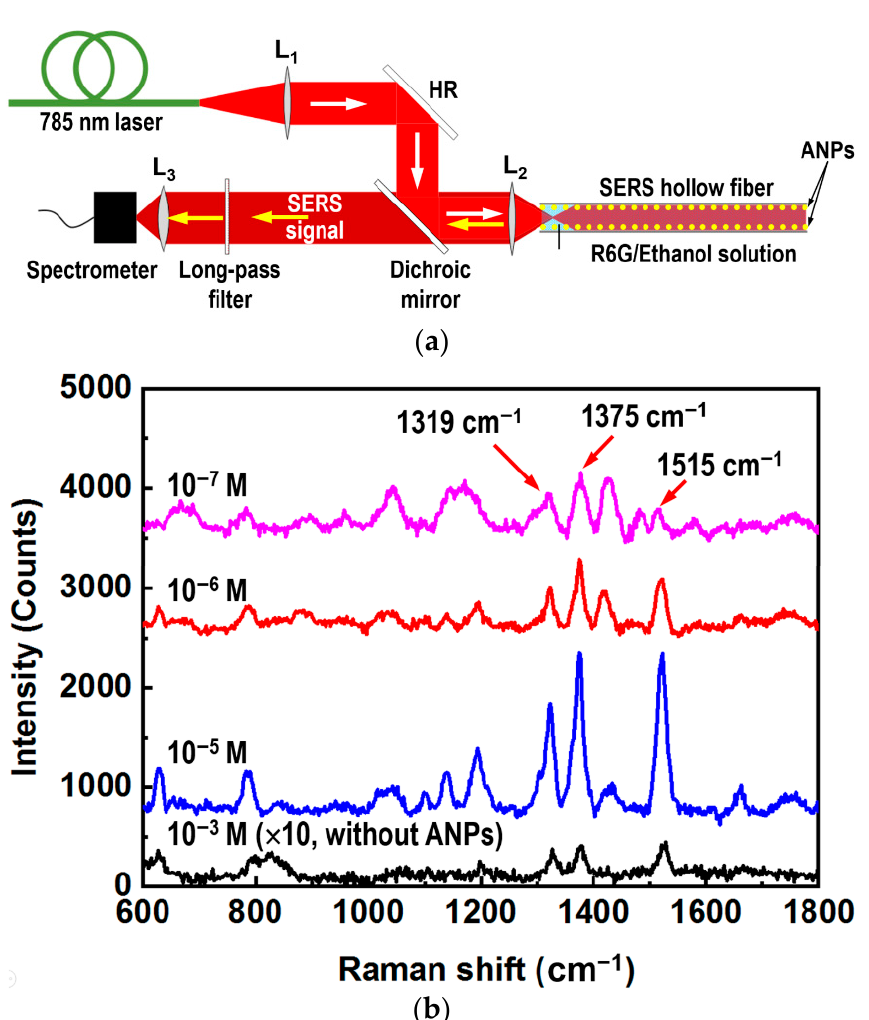
Figure 4. ( a ) Schematic illustration of the SERS detection system. ( b ) SERS signal spectra measured at different concentrations of the R6G/ethanol solution: 10 − 3 M (black), 10 − 5 M (blue), 10 − 6 M (red), and 10 − 7 M (magenta).